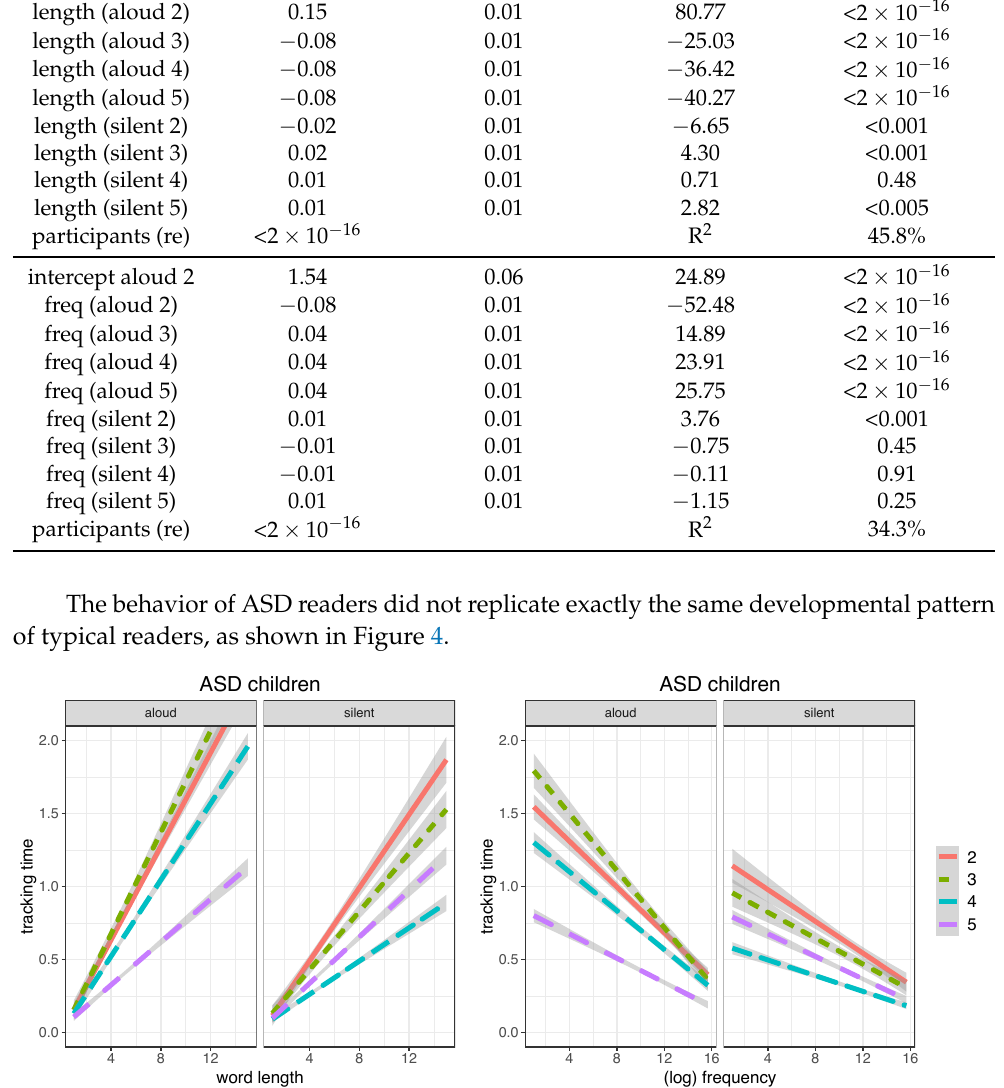
Figure 4. Linear regression plots for word length ( left ) and word frequency ( right ) in ASD children, for the four grade levels (from 2nd to 5th) in the aloud and silent reading modalities, fitting word tracking time (in seconds) (plot obtained with the ggplot2 package, function lm ; shaded areas indicate 95% confidence